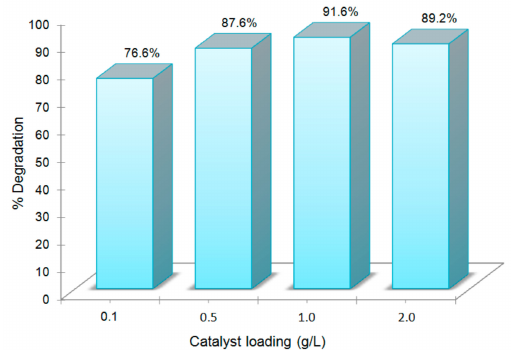
Figure 5. Effect of different amount of H 2 Pp–ZnO on photodegradation efficiency of RhB under visible light